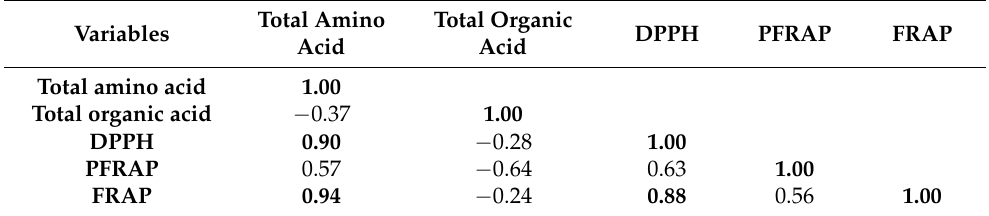
Table 1. Correlation analysis of total amino acid, organic acid contents and their antioxidant capacity assay. (Bold values indicate the significantly difference at p < 0.01). Total Amino Total Organic DPPH PFRAP FRAP Variables Acid Acid Total amino acid 1.00 Total organic acid − 0.37 1.00 DPPH 0.90 − 0.28 1.00 PFRAP 0.57 −